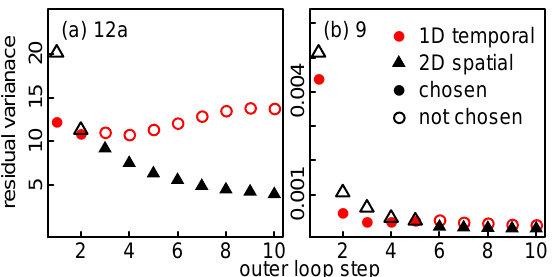
Fig. 2. Demonstration of the step-wise cross-validation scheme. The algorithm compares the variance of the residua at the artificial gap positions and chooses the dimension setting with the lowest residual variance. Shown are, as examples, (a) scenario 12a and (b) scenario 9 with 55% and, respectively, 20% gaps.